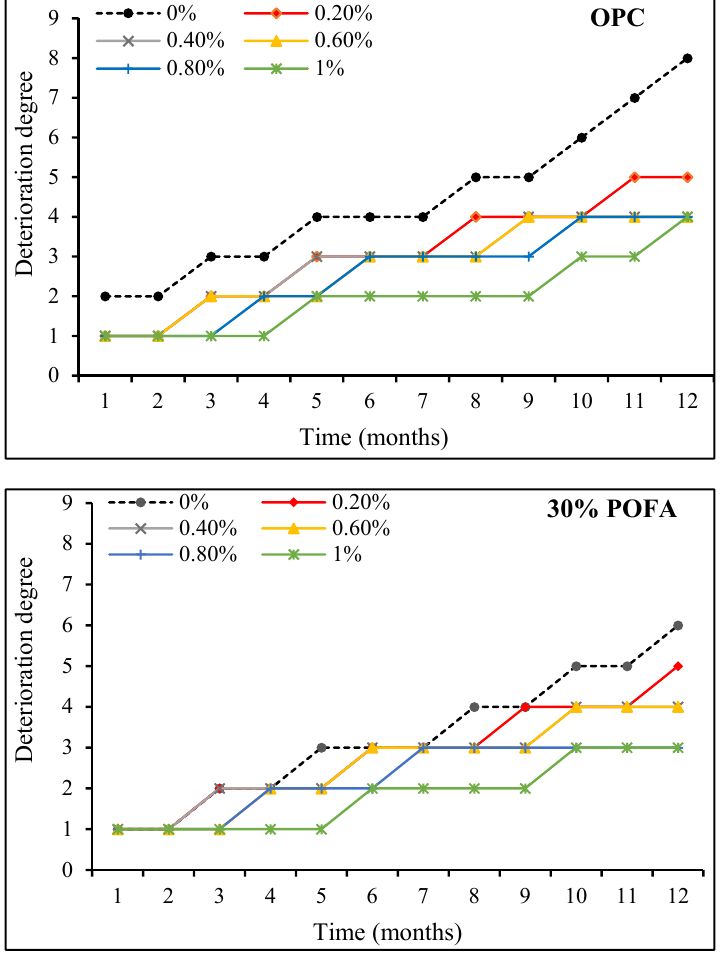
Figure 12. Deterioration degree of concrete specimens comprising WPFT fibers exposed to H 2 SO 4 solutions.